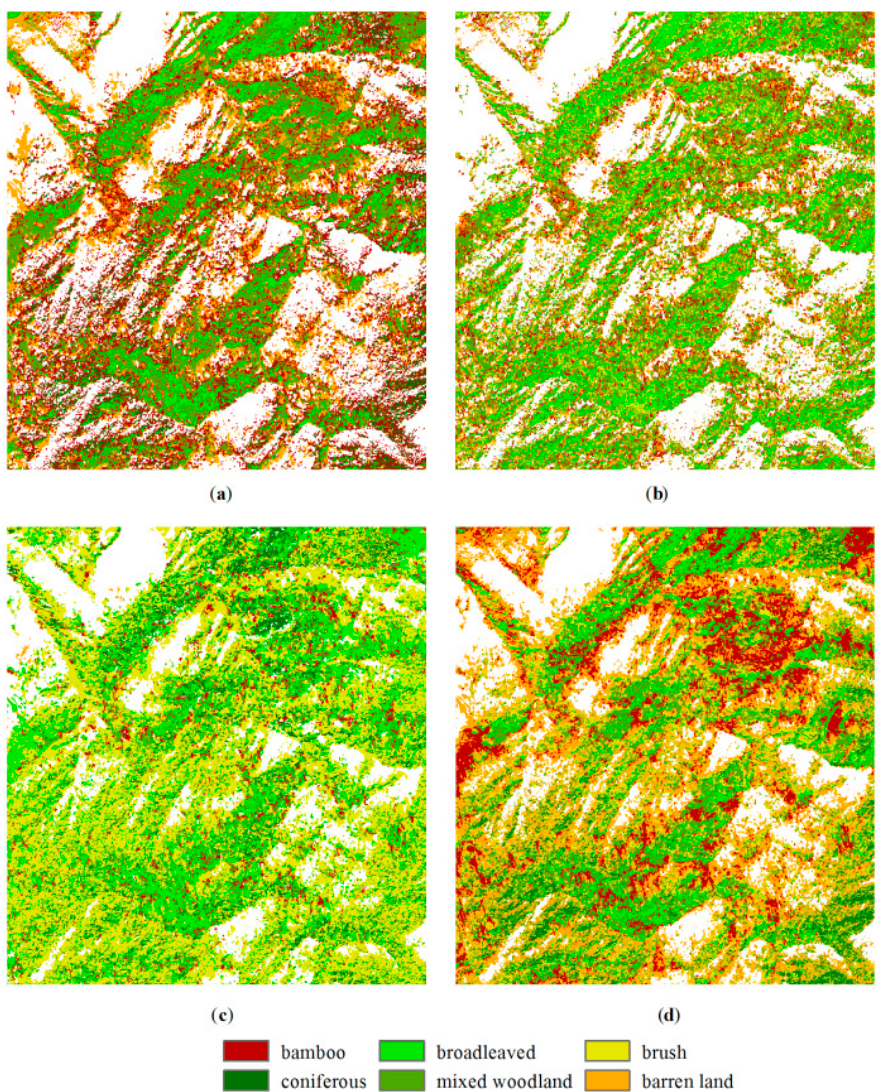
Figure 8. Classified maps generated using ( a ) CART; ( b ) k -NN; ( c ) Bayesian and ( d ) SVM methods based on the original training data.